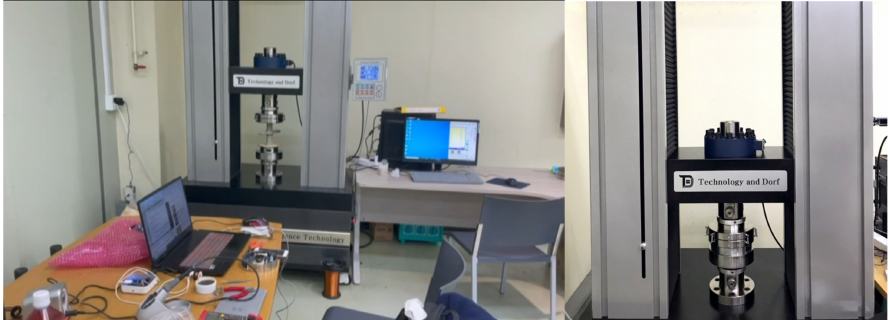
Figure 16. Load-cell compressive load experiment using UTM.